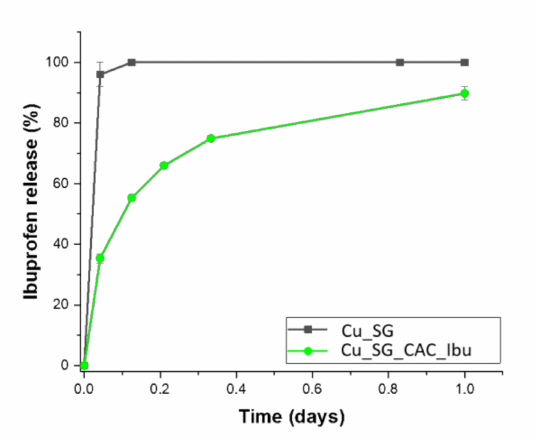
Figure 9. Ibuprofen release profiles of Cu_SG_CAC_Ibu compared with bare samples.